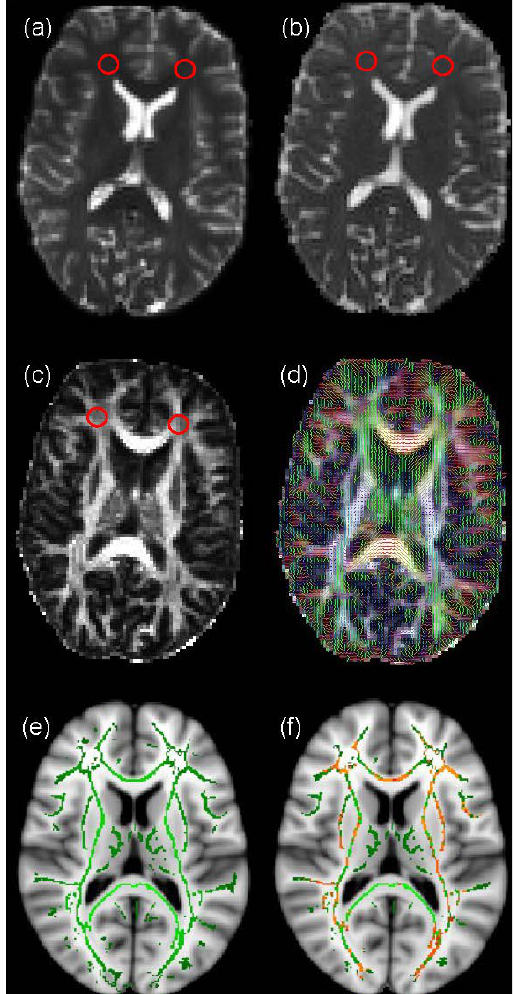
Figure 1. An example of Diffusion Tensor Magnetic Resonance Imaging